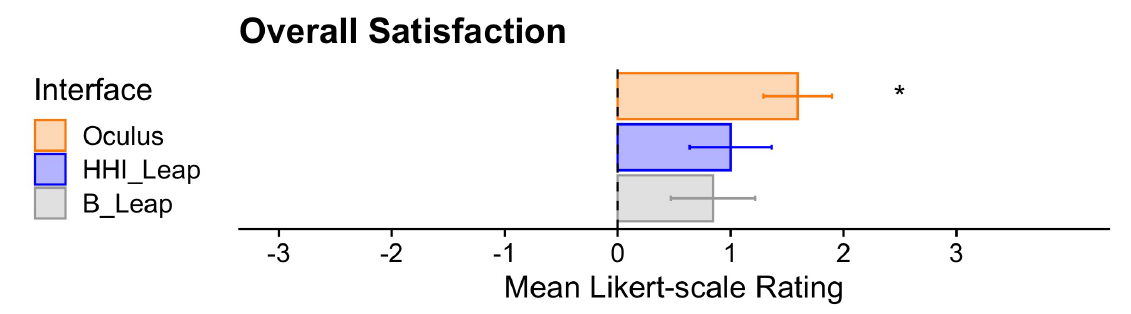
Figure 12. Mean scores for Overall Satisfaction, converted to a scale of − 3 to 3, with 95% CI. * = p < 0.05. Significant difference is between Oculus and HHI_Leap (see Table